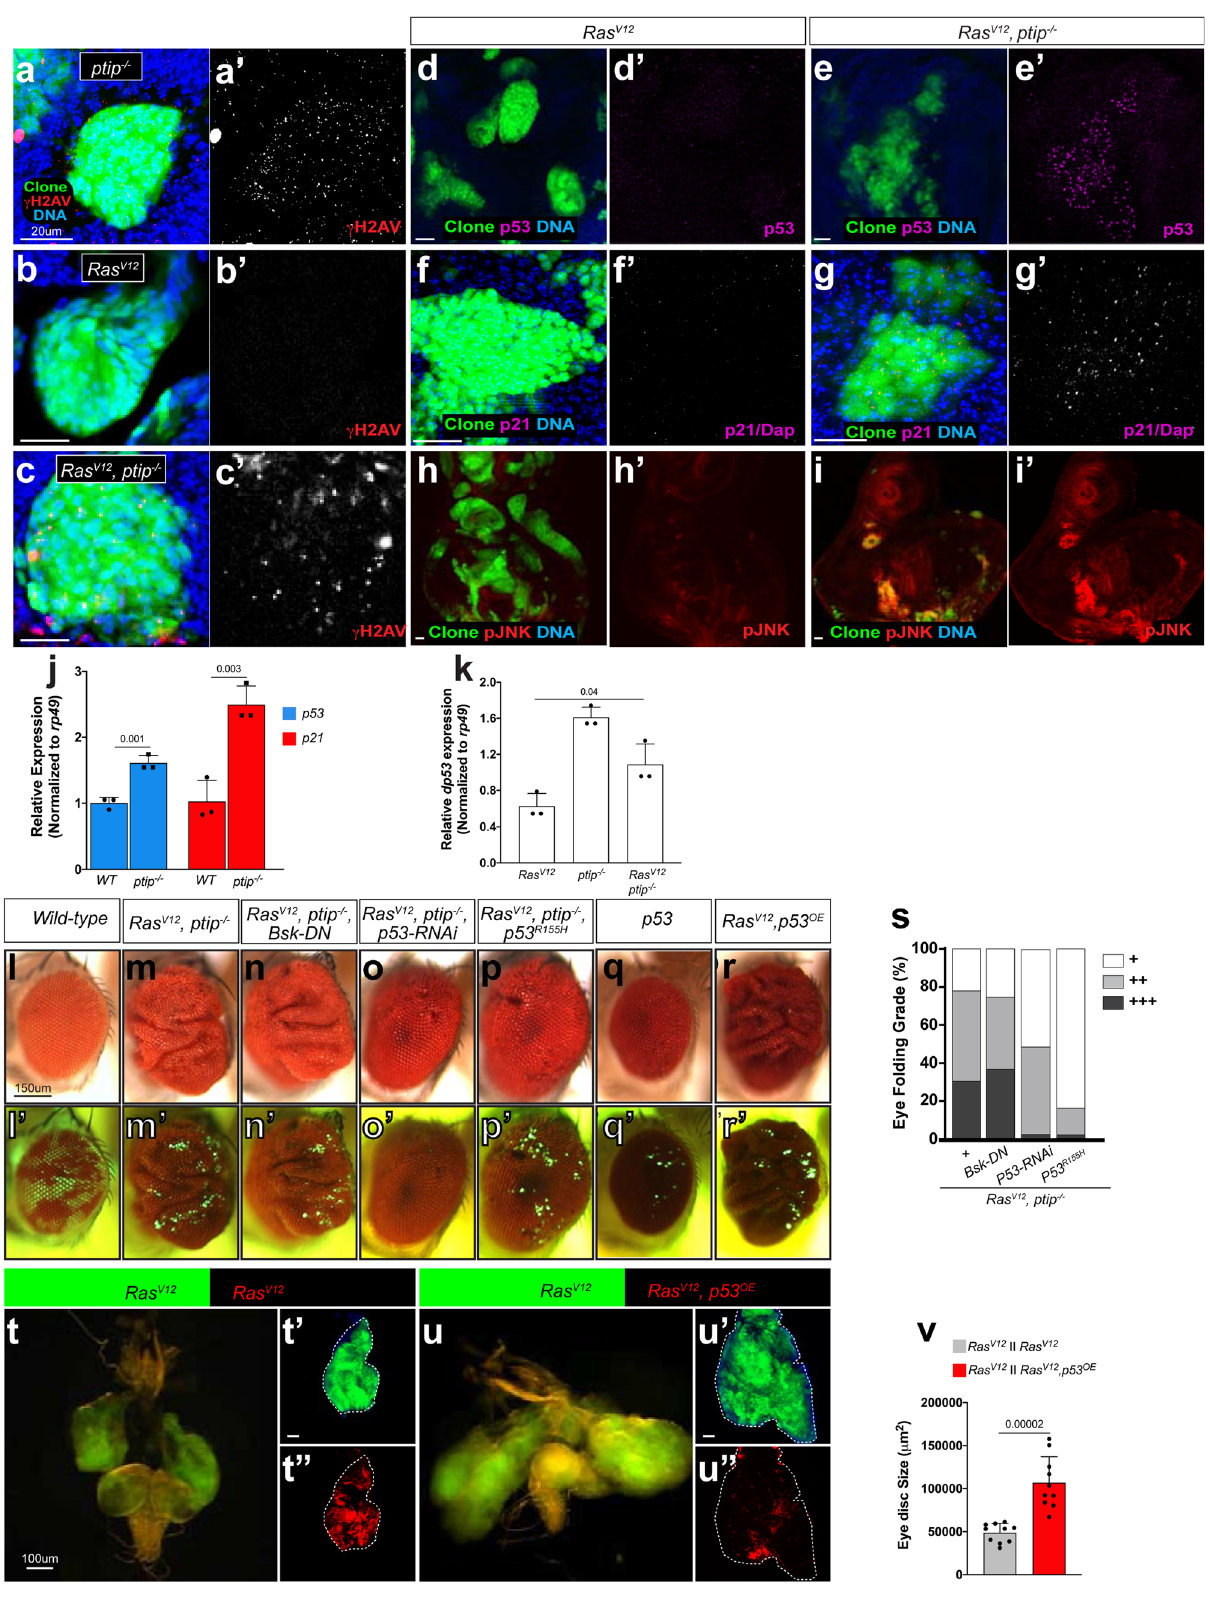
dp53 OE causes Ras V12 cells to upregulate upd (Fig. 3a – b ′ ). In a complementary qPCR approach, we found that dp53 OE causes Ras V12 cells to upregulate all of the upd ligands ( upd1-3 ) in tissues (Fig. 3d). The ptip − / − mutation exerted similar effects on Ras